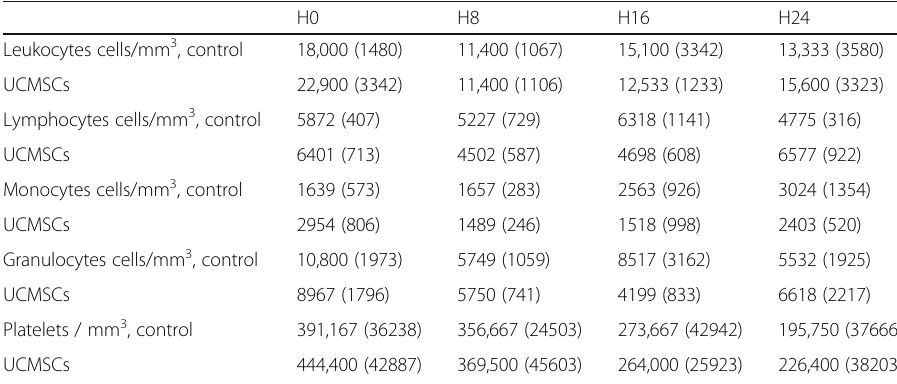
Table 1 Effects of UCMSCs on leukocytes and platelets count H0 H8 H16 H24 Leukocytes cells/mm 3 , control 18,000